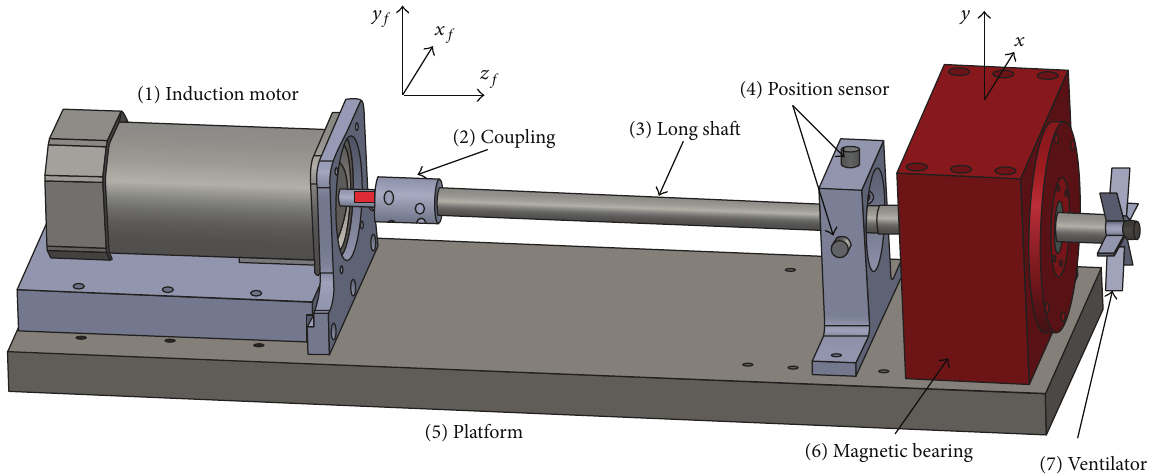
Figure 1: Architecture of a ventilator magnetic bearing